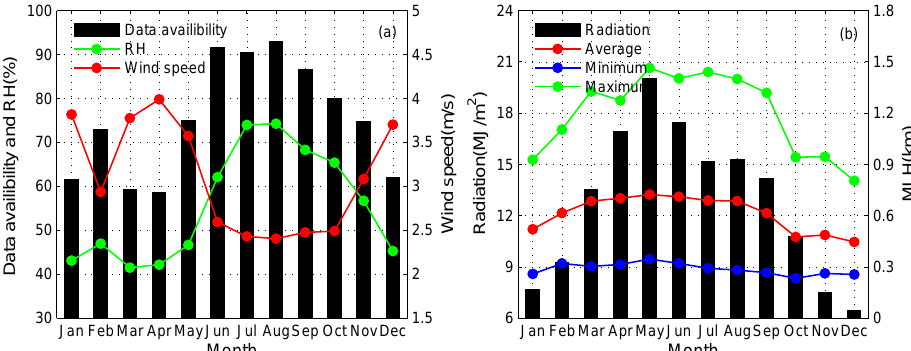
with the highest in May at 1480 ± 448 m and the lowest in December at 787 ± 297